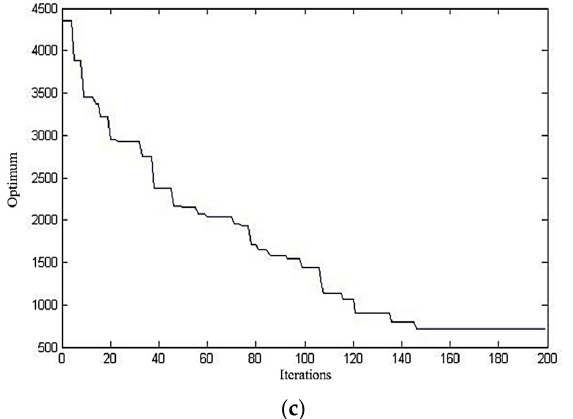
Figure 8. Iteration graph to obtain optimum for L-EVRPTW: ( a ) 80 iterations for Scenario 1; ( b ) 116 iterations for Scenario 2; ( c ) 143 iterations for Scenario 3. Table 12. Optimal delivery paths for EVRPTW-DC.